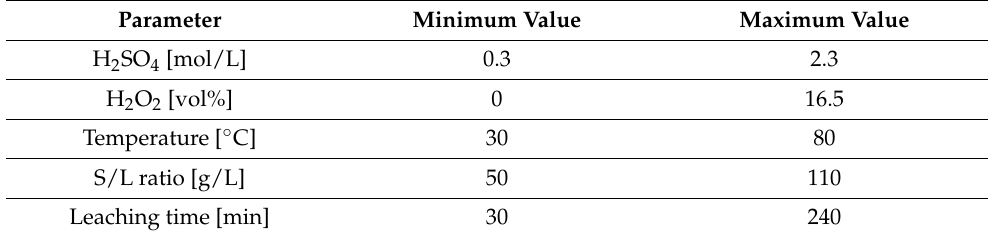
Table 3. Selected parameter limits for the